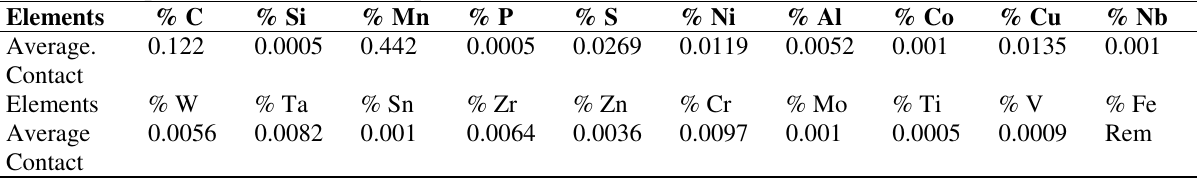
Chemical composition of mild steel sample (ASTM/E/415-14).